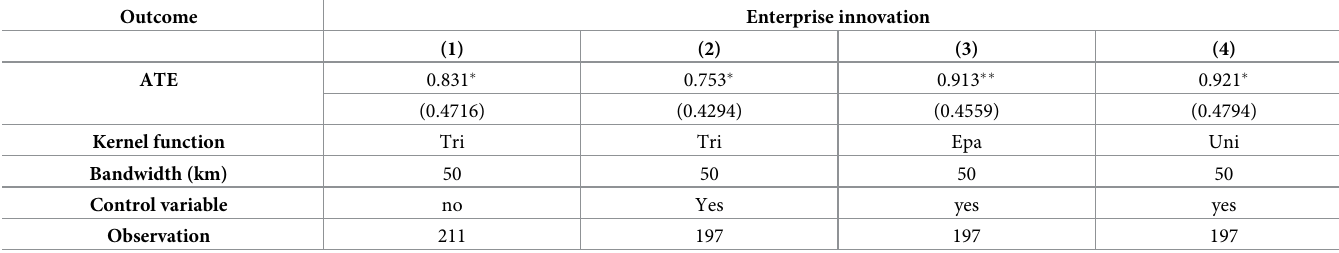
Table 3. Estimated results of